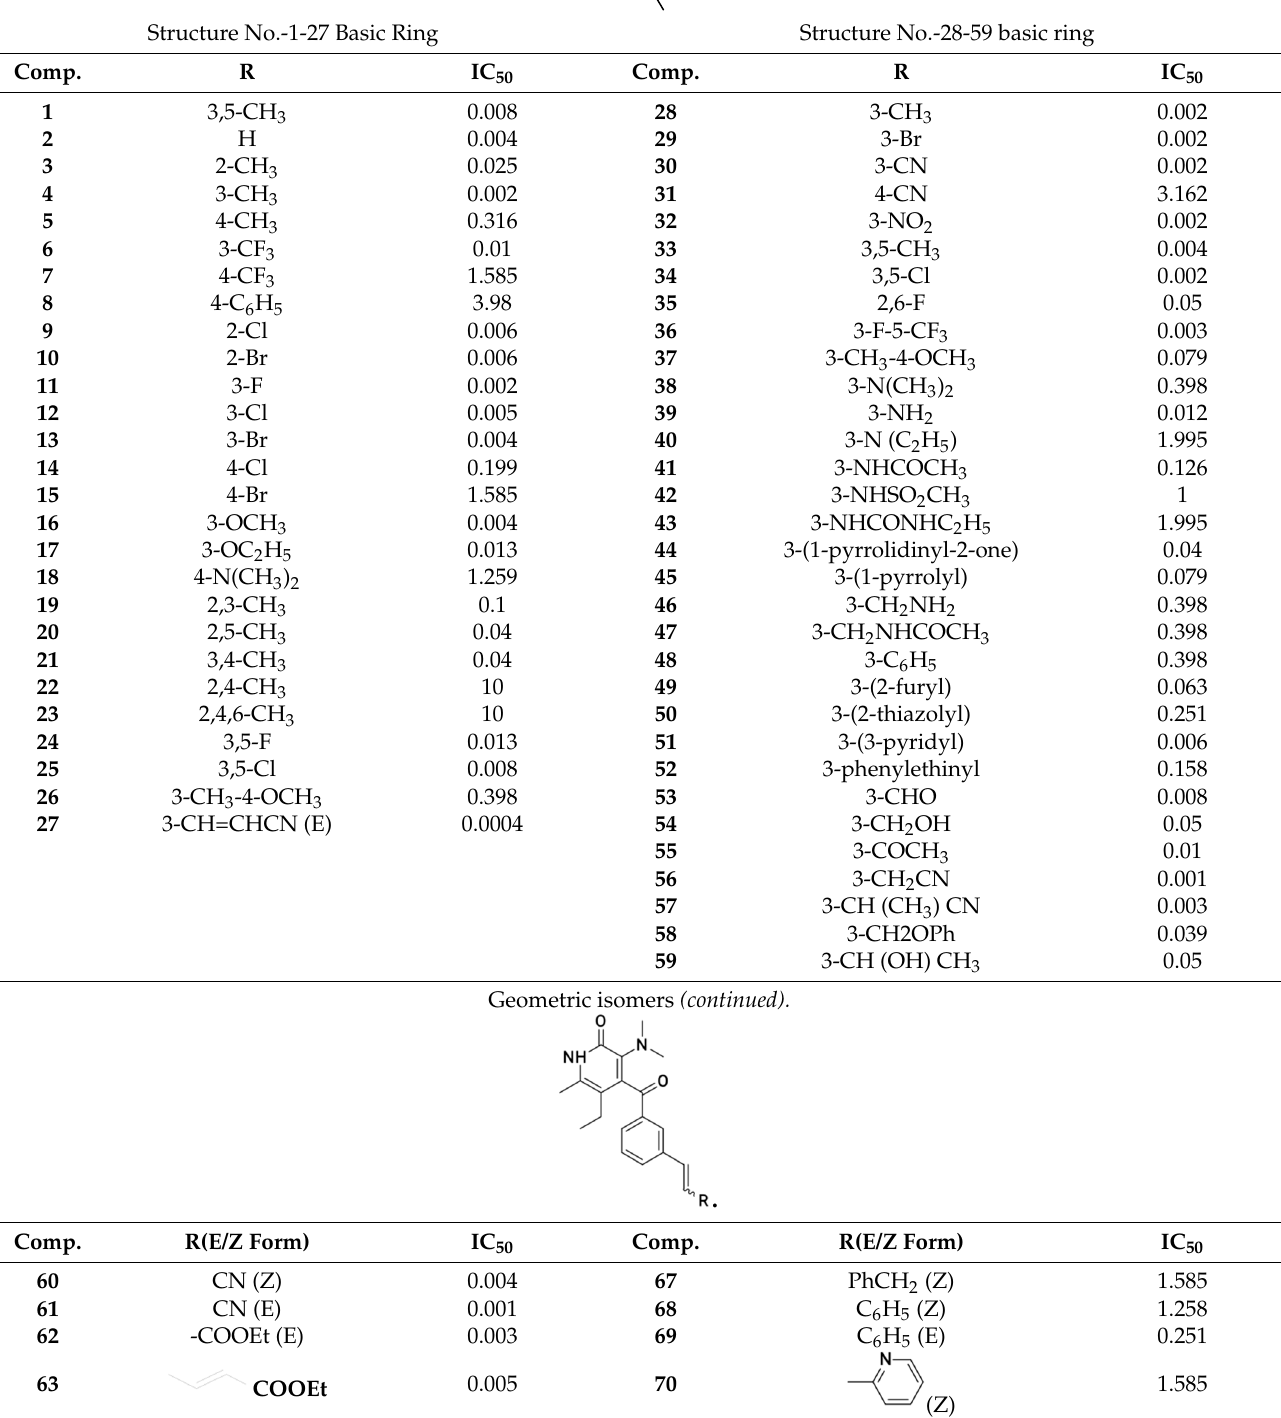
Table 1. Structures of compounds used for pharmacophore model development.